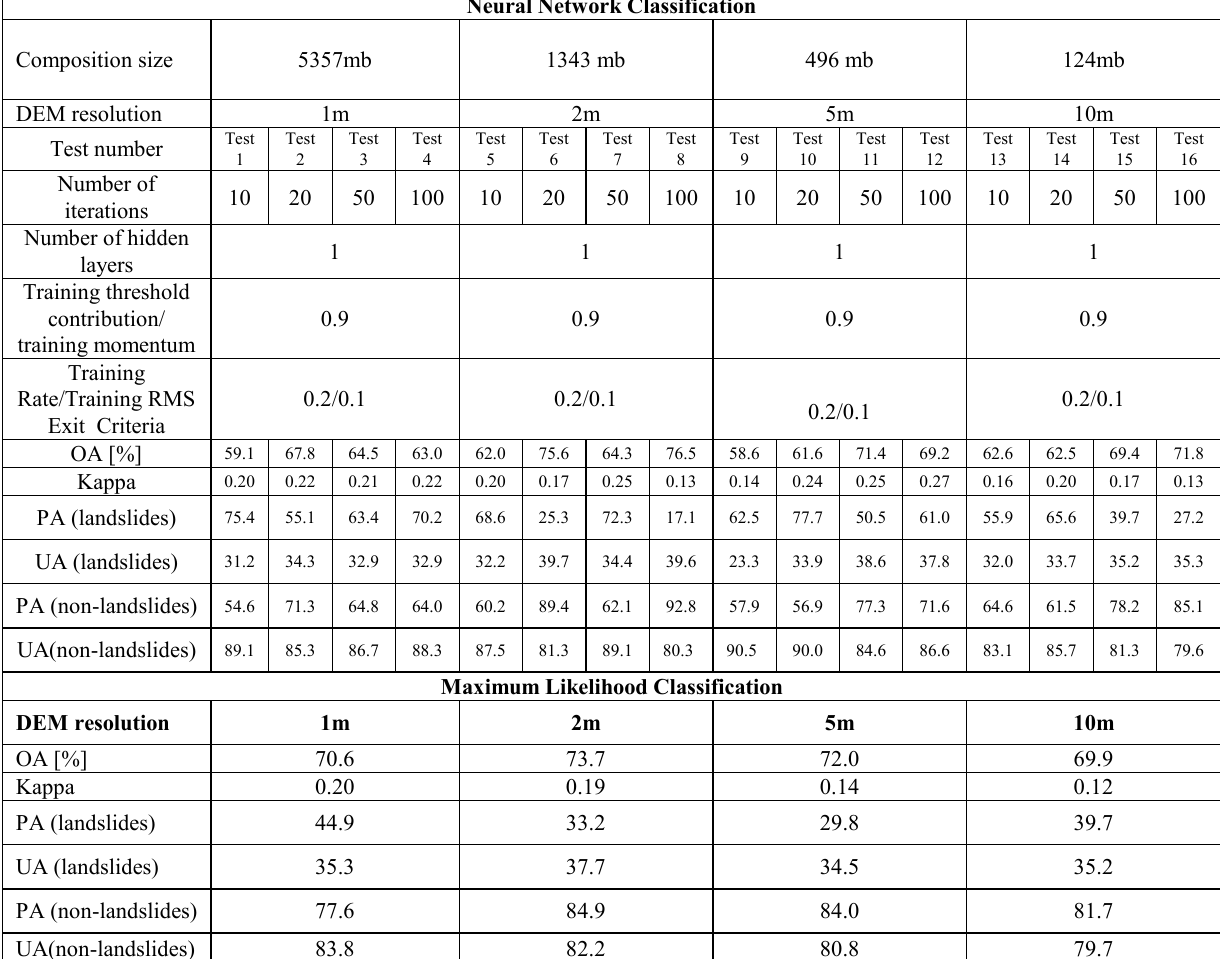
Table 2 Accuracy parameters of classification for FFNN and ML. Explanation in the